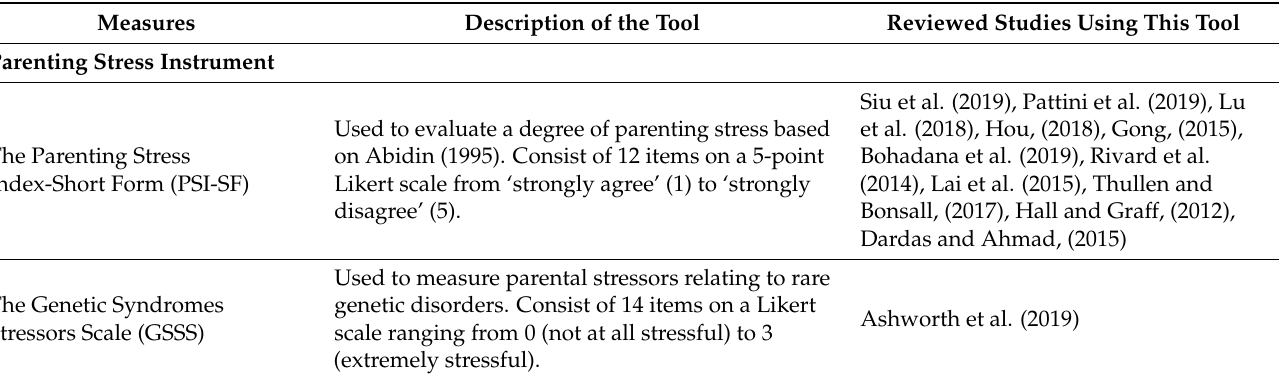
Table 2. Self-administered measurement tools used to examine parenting stress, positive reappraisal coping, and QoL